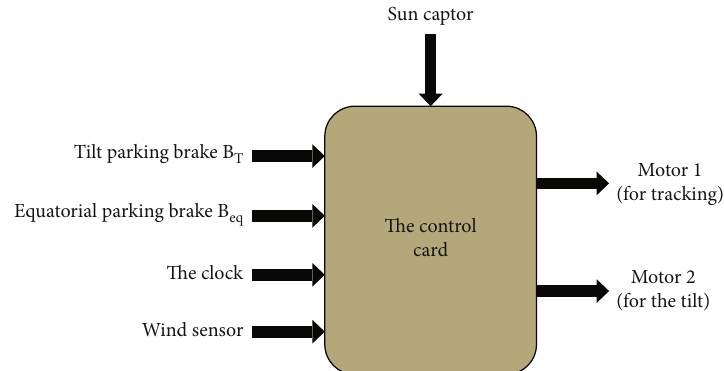
Figure 34: The diagram of the control card.